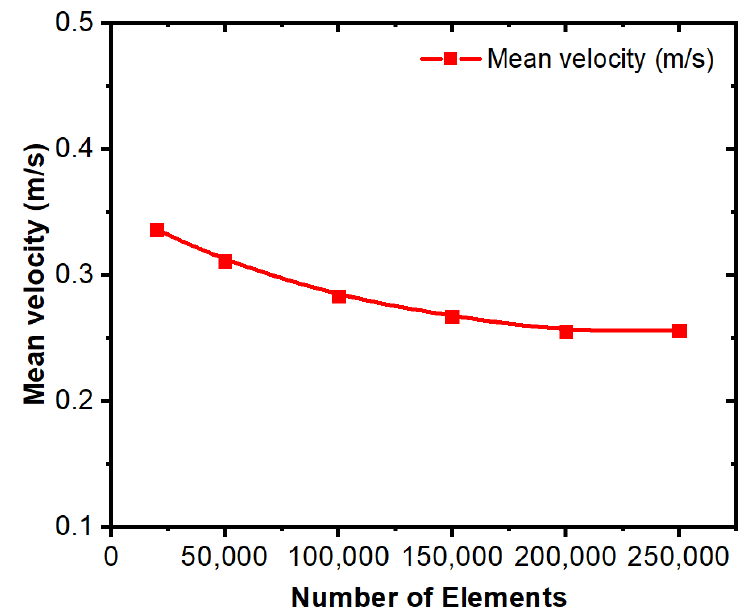
Figure 3. Grid independence test.